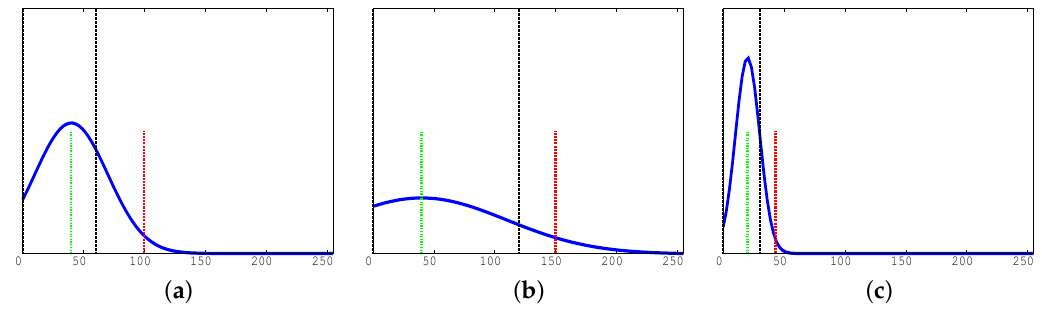
Figure 8. Difference histograms for cells with a detected movements: ( a ) a dark cell, ( b ) a bright cell, ( c ) a hot (white saturated, i.e., dazzled) cell. Vertical lines represent average (green), variance (red), and the cell threshold (higher black line). All Gaussian curves have points in the origin.